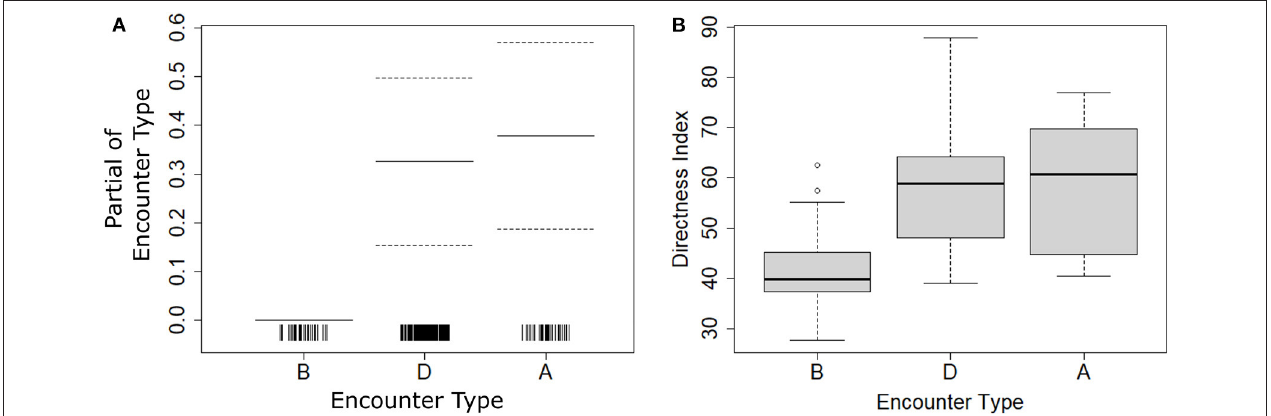
FIGURE 10 | Results from the best fit generalized additive model (GAM) for humpback whale path directness showing (A) model parameter estimates for encounter type (B-Before, D-During, A-After) and (B) model predicted path directness based upon encounter type. Dashed lines in image (A) represent the 95% confidence intervals of the parameter estimate and vertical ticks indicate the locations of observations (i.e., a rugplot).